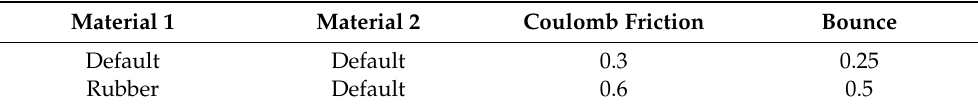
Table 6. Contact